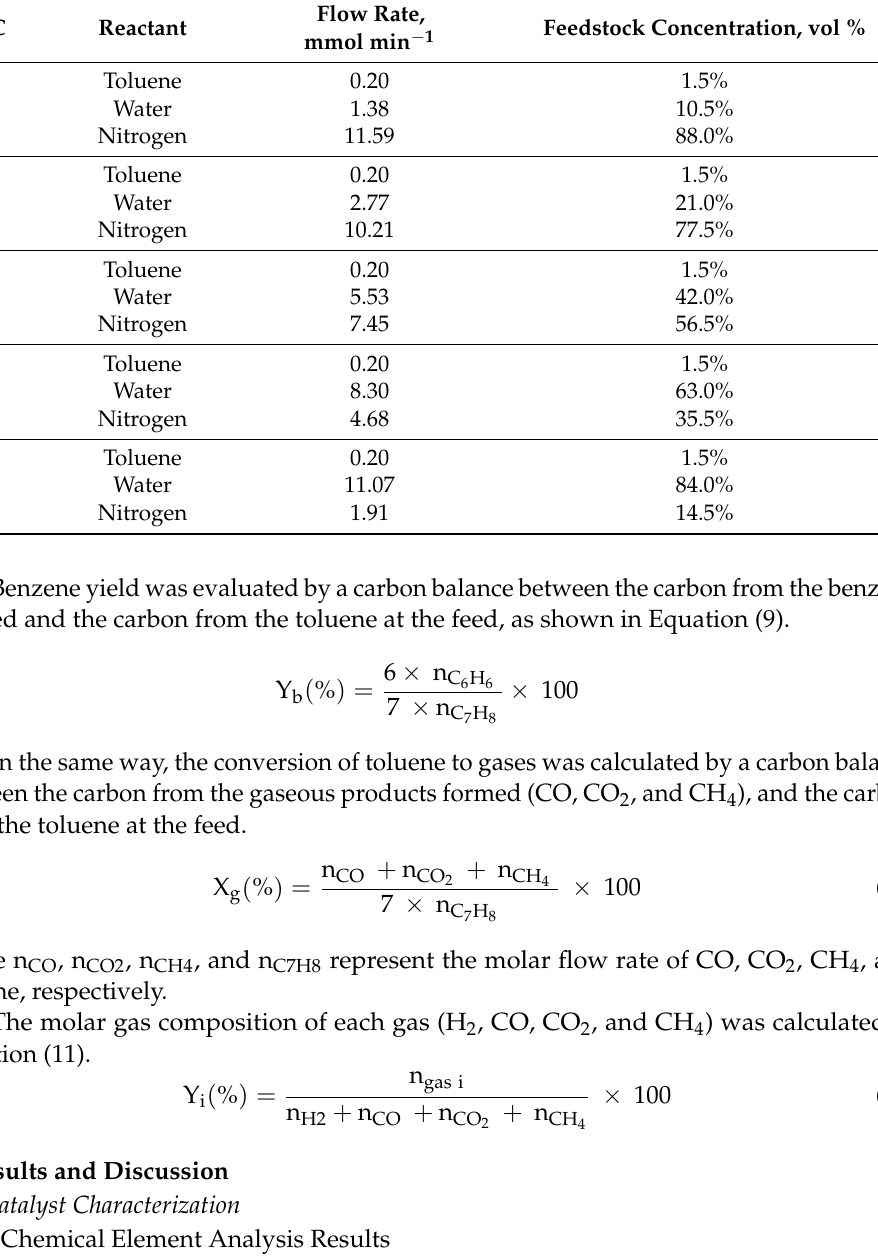
Operating conditions for each steam/carbon molar ratio (S/C ratio) and for W/F = 0.32 g h mol − 1 .